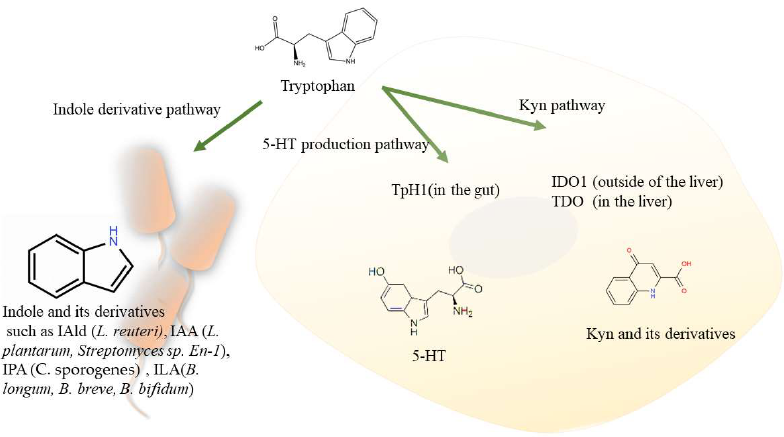
Figure 2. Microbial regulation of host-metabolized tryptophan pathways. Tryptophan could be metabolized to indole and its derivatives via indole derivative pathways in bacteria ( L. reuteri , L. plantarum , and C. sporogenes ), such as IAld, IAA, and IPA, respectively. Meanwhile, tryptophan could be metabolized to TpH1 in host cells via 5-HT production pathways as well as IDO1 (outside of the liver) and TDO (in the liver) via Kyn pathways. Abbreviations: IAld, indole-3-aldehyde; IAA, indole acetic acid; IPA, indole propionic acid; TpH1, Tryptophan hydroxylase I; 5-HT, 5-hydroxytryptamine; IDO1, indoleamine 2,3-dioxygenase 1; TDO, Trp-2,3-dioxygenase; Kyn, kynurenine. To date, a few Trp-metabolizing microbial species that can activate AHR have been Table 1. AHR-activating-microbiota biotic Lactobacillus spp. contains many species that can produce AHR ligands. Targeted